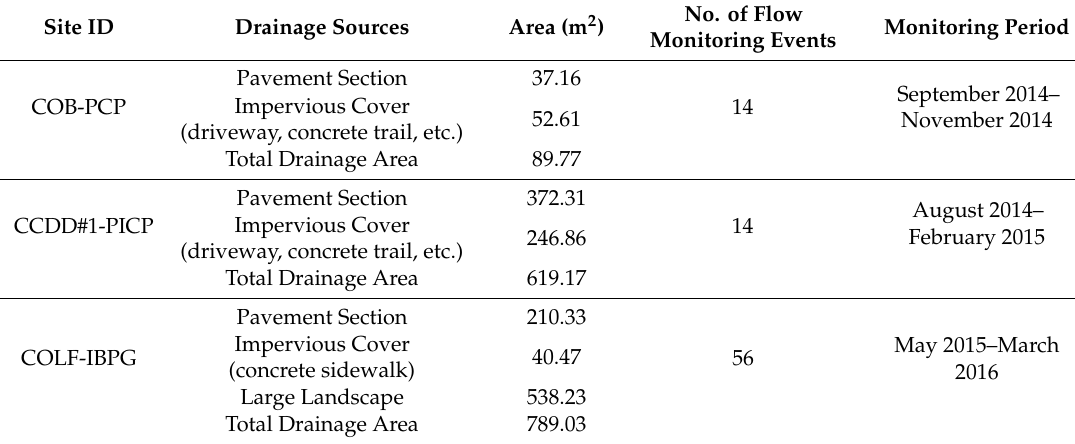
Figure 1. Three types of monitored permeable pavements in different parking lots at Lower Rio Grande Valley (LRGV) sites. From the left: ( A ) Porous Concrete Pavement (PCP), ( B ) Permeable Interlocking Concrete Pavement (PICP), and ( C ) Interlocking Block Pavement with Gravel (IBPG). Table 1. Summary of site characteristics and flow monitoring events at the outfall of the monitored permeable pavements. COB: City of Brownsville, CCDD#1: Cameron County Drainage District #1 Cascade Park, COLF: City of La Feria.